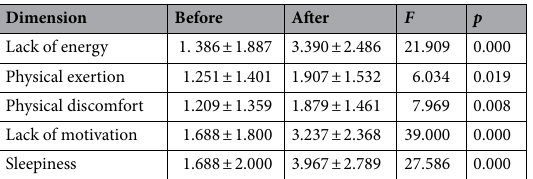
Table 1. Analysis of the difference between the five dimensions of the SOFI before and after the test.